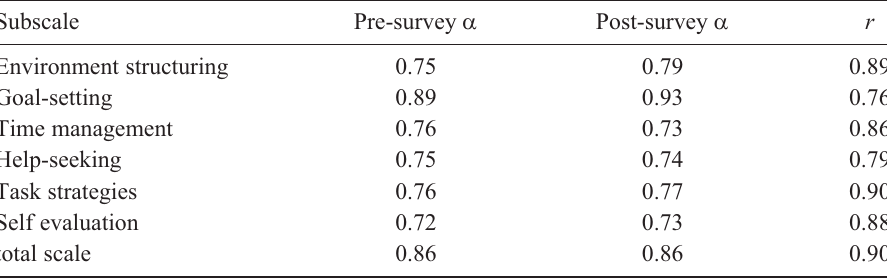
Table 1. Internal consistencies for each